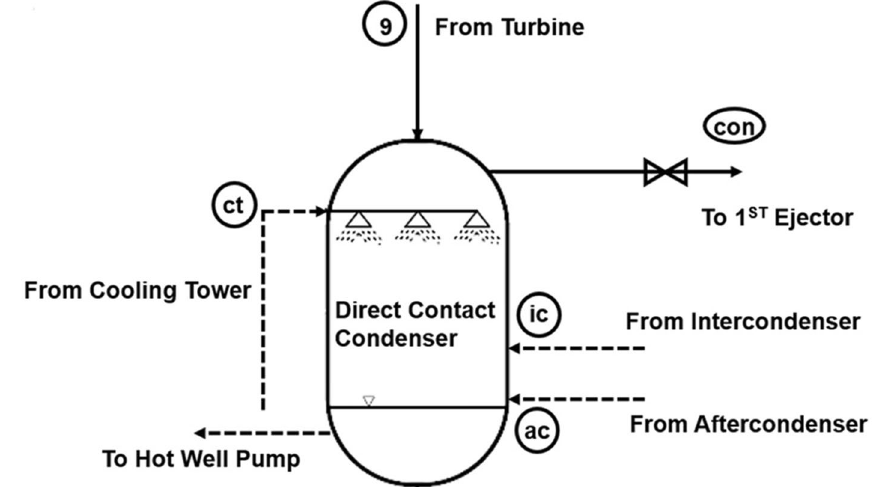
Fig. 7 Direct-contact condenser flow diagram. The steam leaving the turbine is directed into the condenser where it mixes with the cold-water spray from the cooling tower and the cooling gas from the NCG exhaust